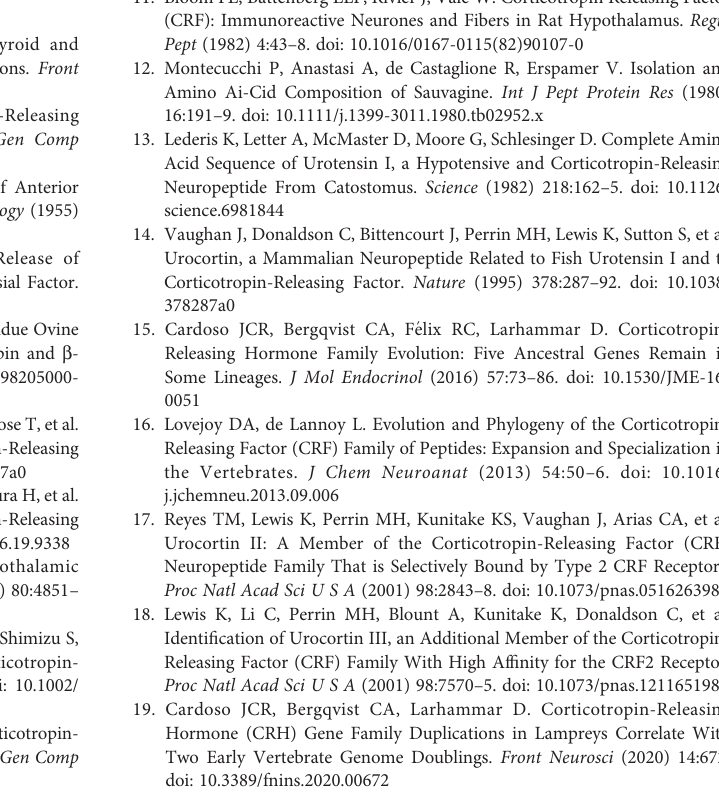
qPCR of the crh1 and crh2 paralog genes and gene references in European eel and Atlantic salmon. Supplementary Figure 1 | Venn diagram showing the distribution of the gene family members on the crh-bearing chromosomes in the reed fi sh genomes. Supplementary Figure 2 | Maximum-likelihood phylogenetic tree of CRH precursor amino acid sequences with a focus in actinopterygian